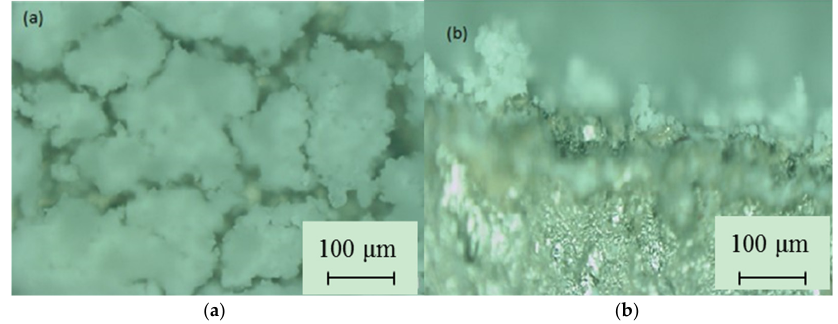
Figure 9. Micrographs of suspension sprayed coating deposited at d = 60 mm. ( a ) Top ‐ surface; ( b ) Cross ‐ section.